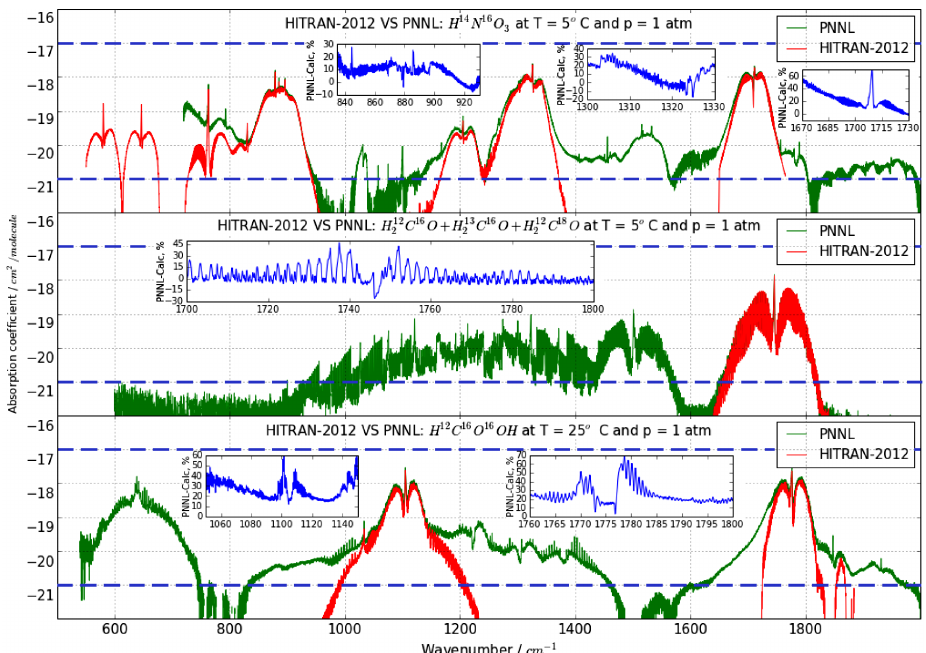
Figure 3. Comparison of HITRAN with PNNL: from top to bottom HNO 3 , H 2 CO, HCOOH. The area inside the thick dashed horizontal grid lines corresponds to the area shown in the panels of Fig. 1 in the BG article.